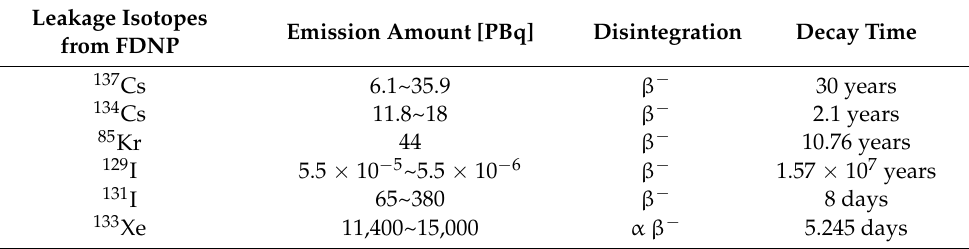
Table 1. Some RIs released into the atmosphere during the Fukushima nuclear accident in 2011. Leakage Isotopes from